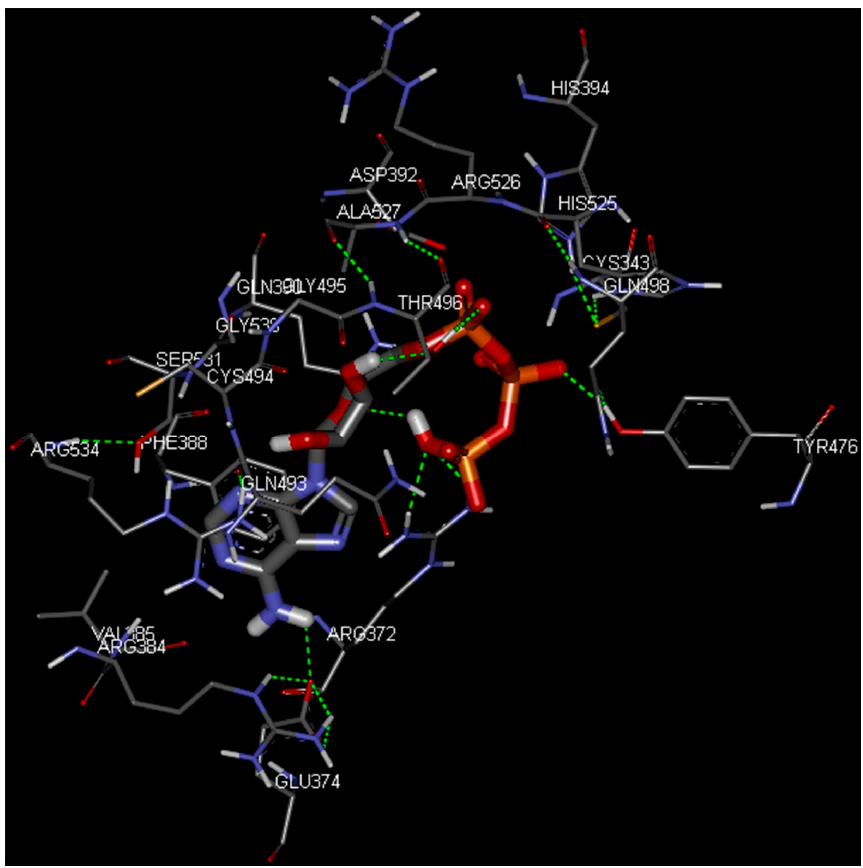
Figure 3. Predicted binding mode of ATP, as determined by docking of the ligands in the BaThrRS homology model.